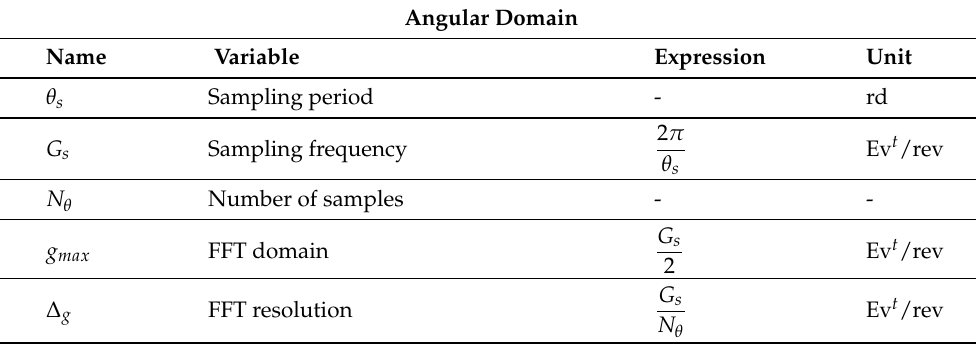
Table 3. Angular domain and FFT